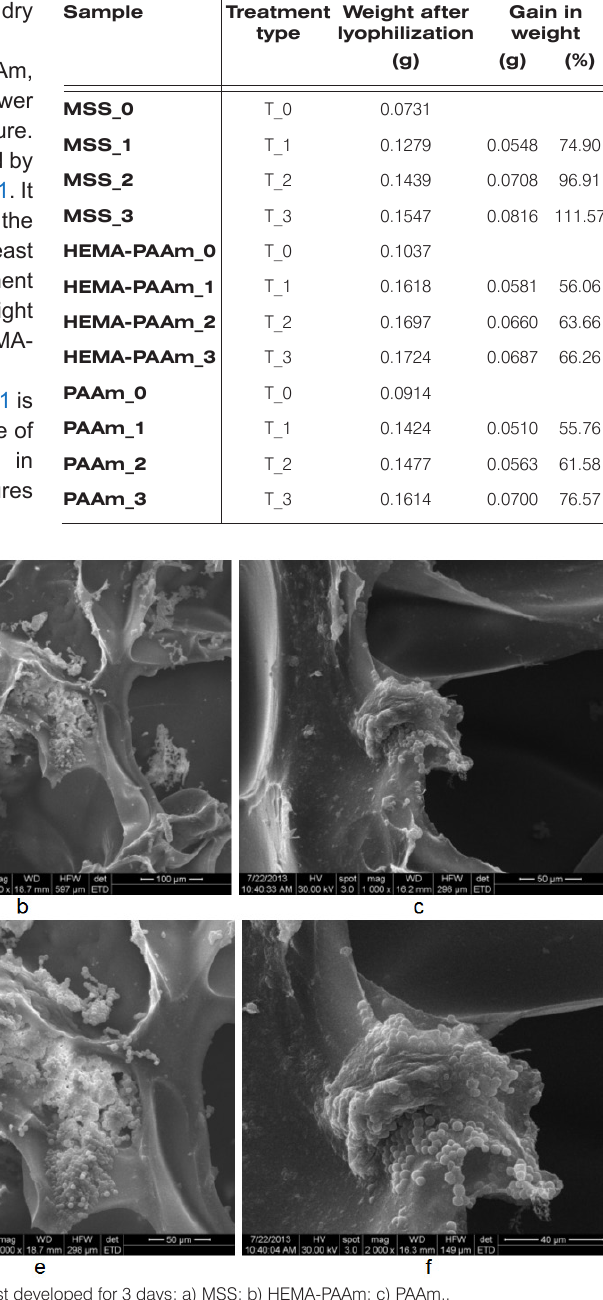
Table 1. Gravimetric data concerning the yeast growth on the supports.